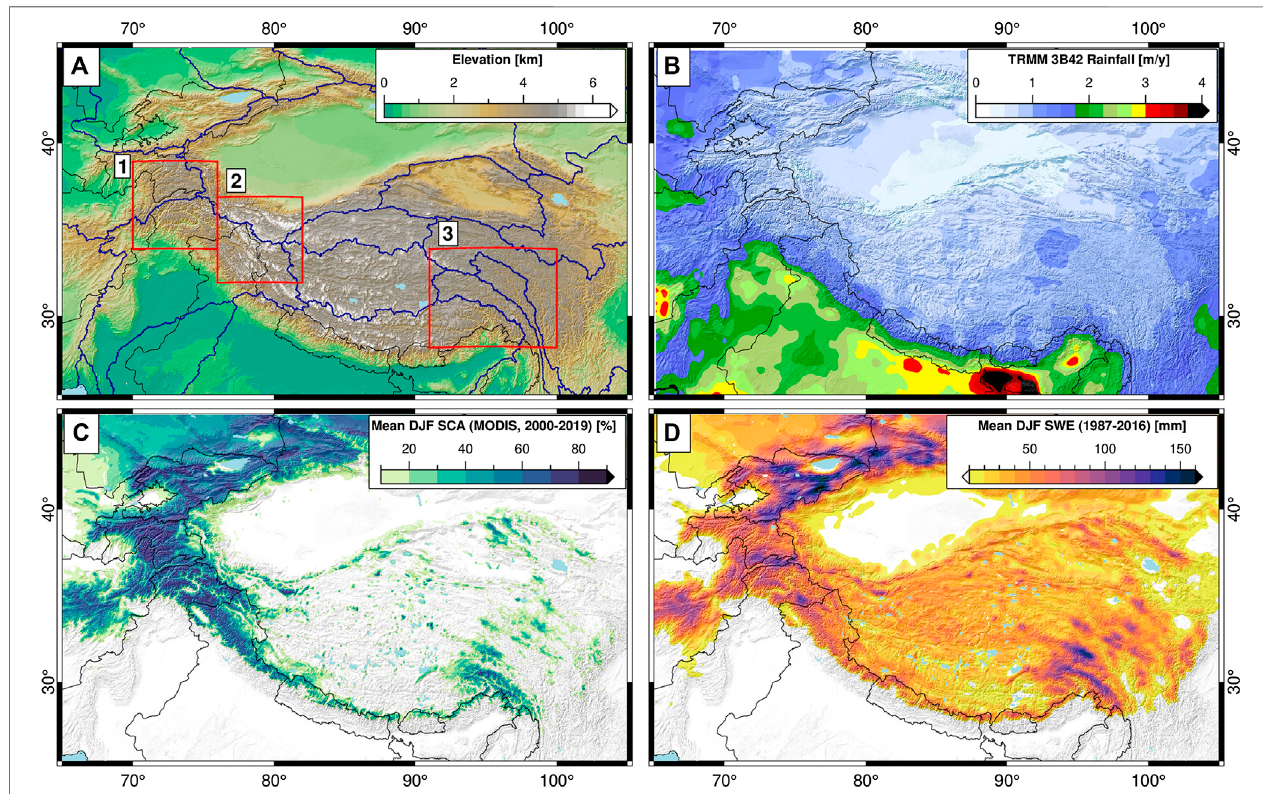
FIGURE1 | Study area (A) topography (B) averageannual Tropical Rainfall MeasurementMissionprecipitation sum [0.25 ° , 1998 – 2018 (Huffman et al., 2007)], (C) average December-January-February (DJF) snow-covered area percentage from MODIS MOD10A [500 m, 2000 – 2019 (Hall and Riggs, 2016)], and (D) average DJF snow-water equivalent (SWE) volume from 3.125 km resolution special sensor microwave imager and special sensor microwave imager/sounder (1987 – 2016). Deep snow is generally con fi ned to high-elevation regions. Blue outlines on (A) show major watersheds from HydroBASINS (Lehner and Grill, 2013), black lines show international borders. Labeled boxes indicate sub-areas shown in Figures 4 and 8 .